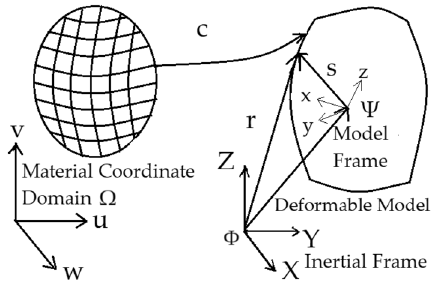
Figure 4. Visualizes the deformable model framework; mapping from the material coordinate domain to the deformable